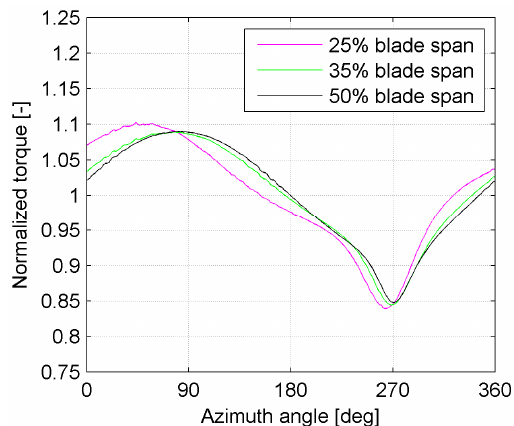
Figure 11. Normalized torque contribution at different span locations of the blade in FM + T configuration.